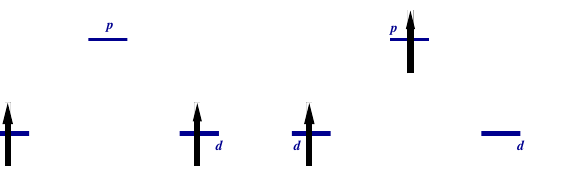
Figure 7. Scheme of | t d (cid:105) and | ZRT (cid:105) states (33),(34) in a “Cu-O-Cu”